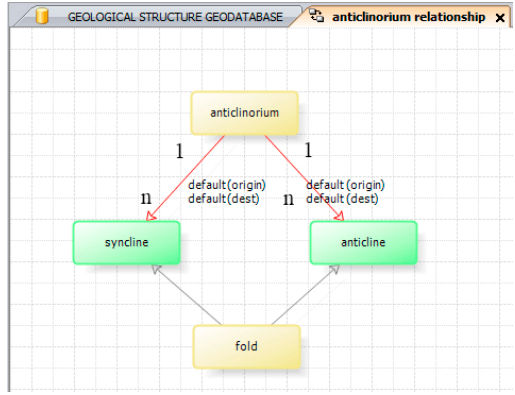
Figure 7. Association rule of an anticlinorium.